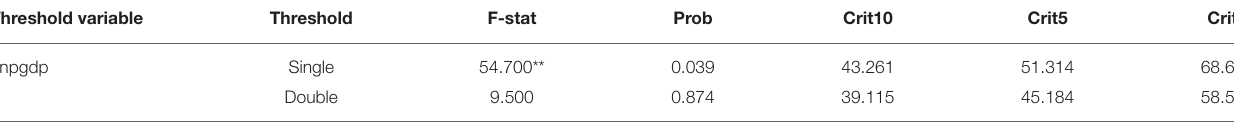
TABLE 3 | Tests for threshold effects between GDP and public health. Threshold variable